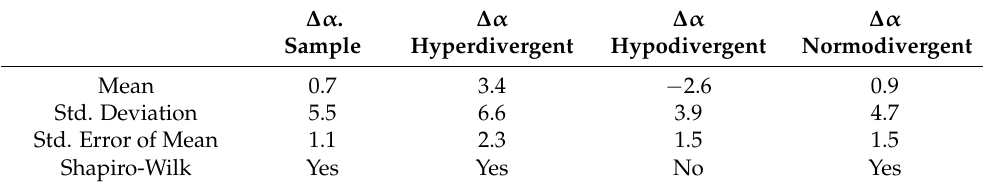
Table 2. The average ∆ α referred to the sample.